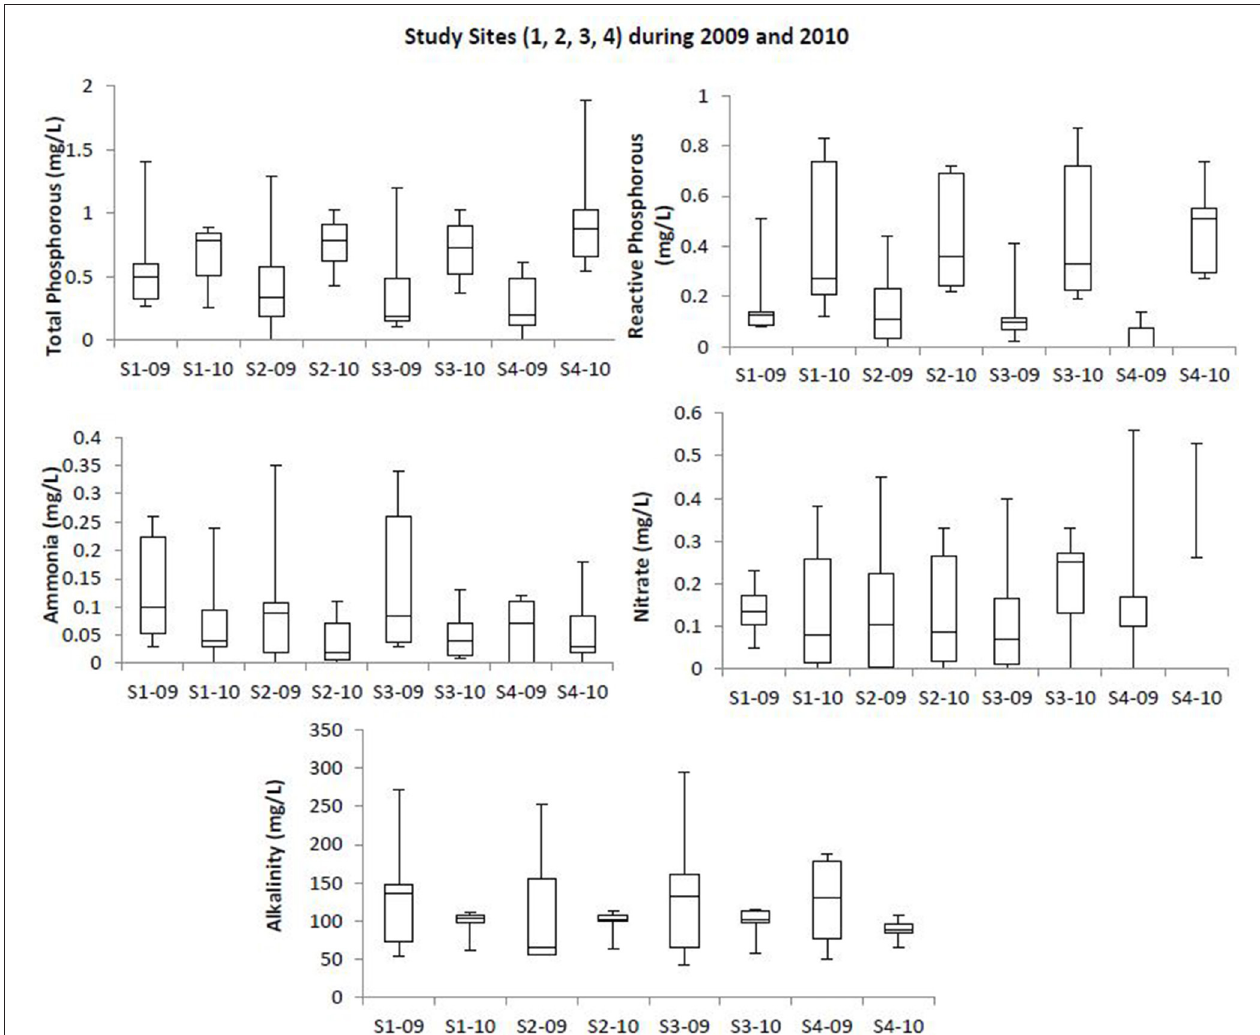
FIGURE 3 | Box plot showing trends at the study sites for total phosphorous, reactive phosphorous, ammonia, and alkalinity profiles at the upstream and downstream sites of Blackbird Creek watershed during 2009 and 2010. Study sites within the images are labeled as S1-09 (Site 1, 2009); S1-10 (Site 1, 2010); S2-09 (Site 2, 2009); S2-10 (Site 2, 2010); S3-09 (Site 3, 2009); S3-10 (Site 3, 2010); S4-09 (Site 4, 2009); S4-10 (Site 4,